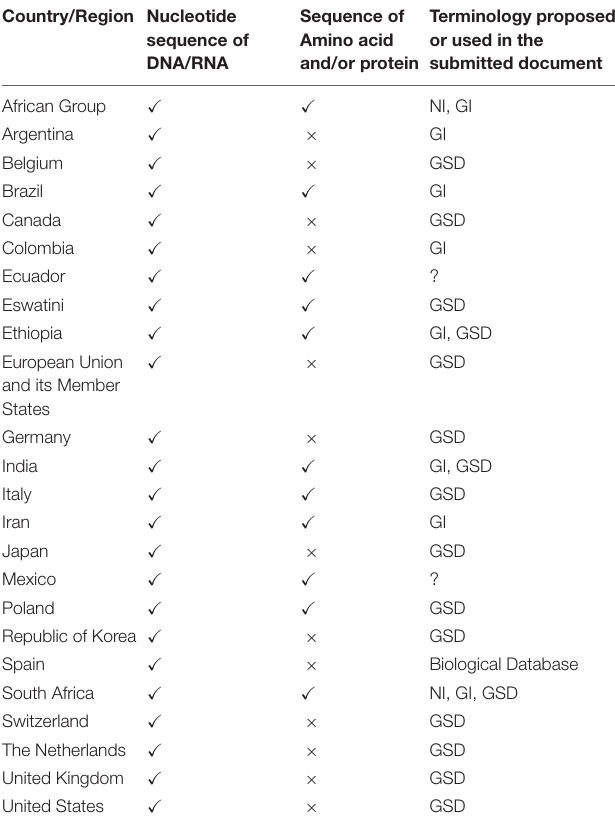
TABLE 2 | Views on terminology related to DSI. Country/Region Nucleotide Sequence of sequence of Amino acid DNA/RNA and/or